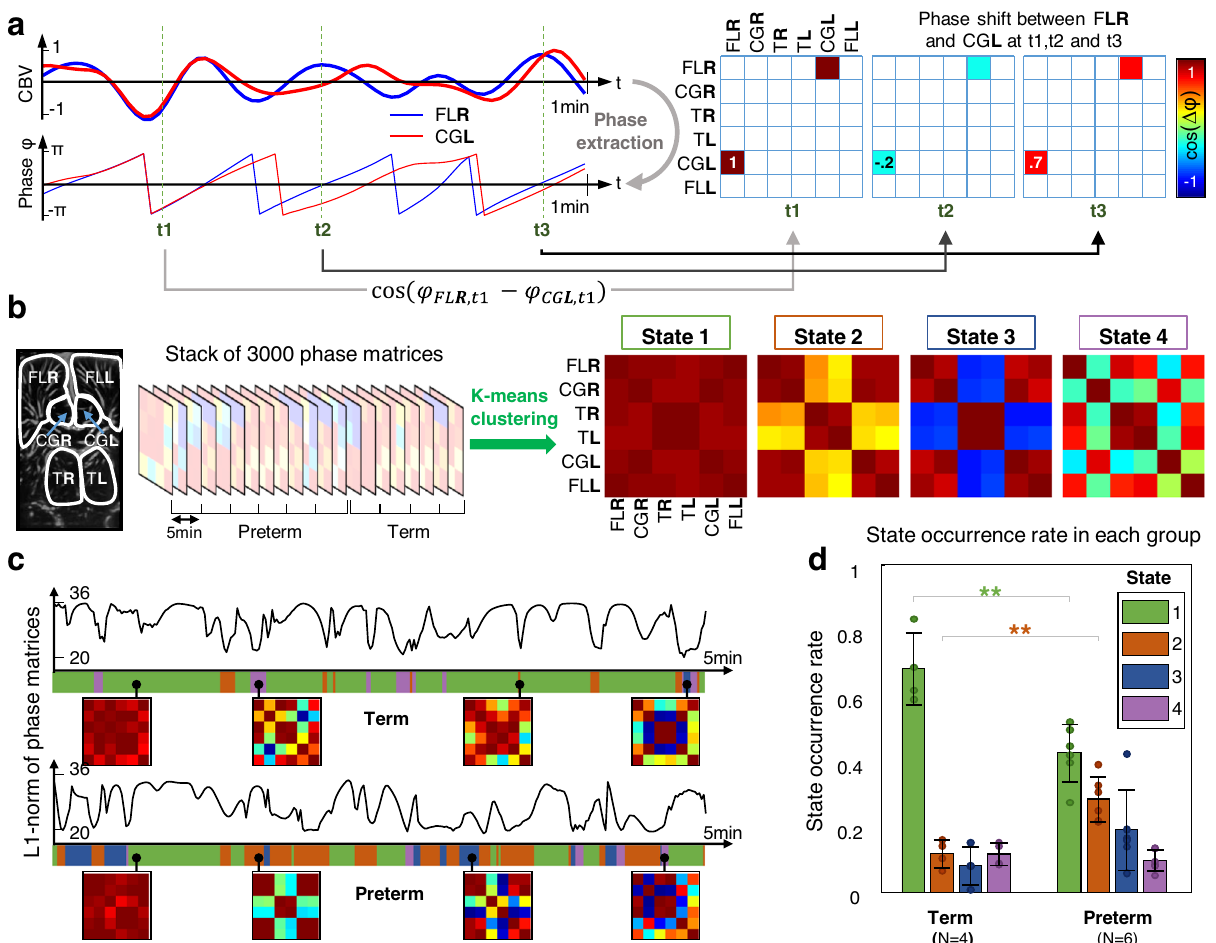
Fig. 4 Dynamic connectivity reveals a disconnection of thalamo-cortical networks for preterm neonates. ( CBV cerebral blood volume, FL frontal lobe, CG cingulate gyrus, T thalamus, R/L right/left) a Construction of the phase matrices coef fi cients for the right frontal lobe (FLR) and the left cingulate gyrus (CGL). The instantaneous phase is extracted from the CBV time courses. The cosine of the phase shift between FLR and CGL is reported every 1s in the phase matrix. b Si cerebral areas are included in the analysis: the frontal lobes, cingulate gyri and thalamus in left and right hemispheres. The phase matrices are concatenated in the time dimension for 10 independent 5-min-long acquisitions involving six preterm and four term-born neonates. Unsupervised k-means with L 1 norm (i.e., Manhattan distance) is applied on the full phase matrix stack resulting in four connectivity states. The corresponding color scale is de fi ned on the right of a . c Typical L 1 norm time course for acquisitions on one term infant and on preterm neonate. The fl uctuations of these curves give information on the dynamic phase matrix changes. The closest state to the current phase matrix is encoded in the color ribbon below each curve. Four examples of phase matrices are shown in small square boxes for each patient. The colors in the ribbon representing the different states are de fi ned in d legend box. d Occurrence rate of each state averaged on each population (** p = 0.003, one-way ANOVA with post hoc Tukey ’ s tests). Error bars represent the standard deviation. Center of error bar is the mean value. N = number of independent patients in each group, with one acquisition per patient. Source data are provided as a Source Data fi